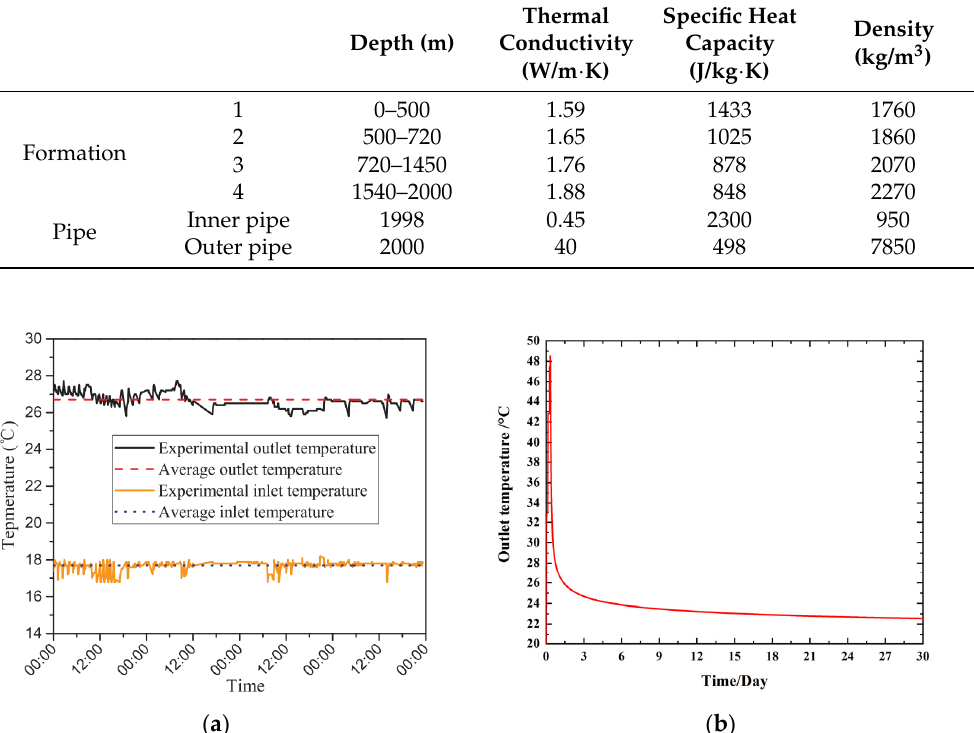
Table 3. Specific parameters of the demonstration project.